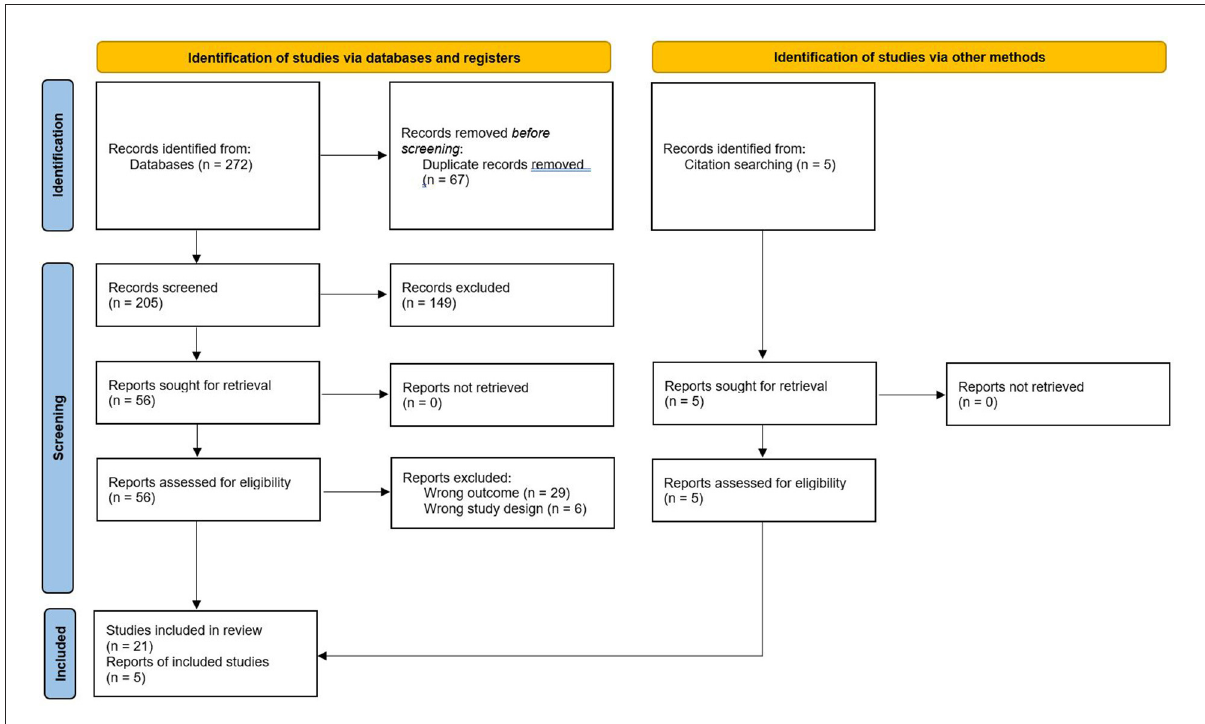
FIGURE1 PRISMA flow diagram. From: Page et al.